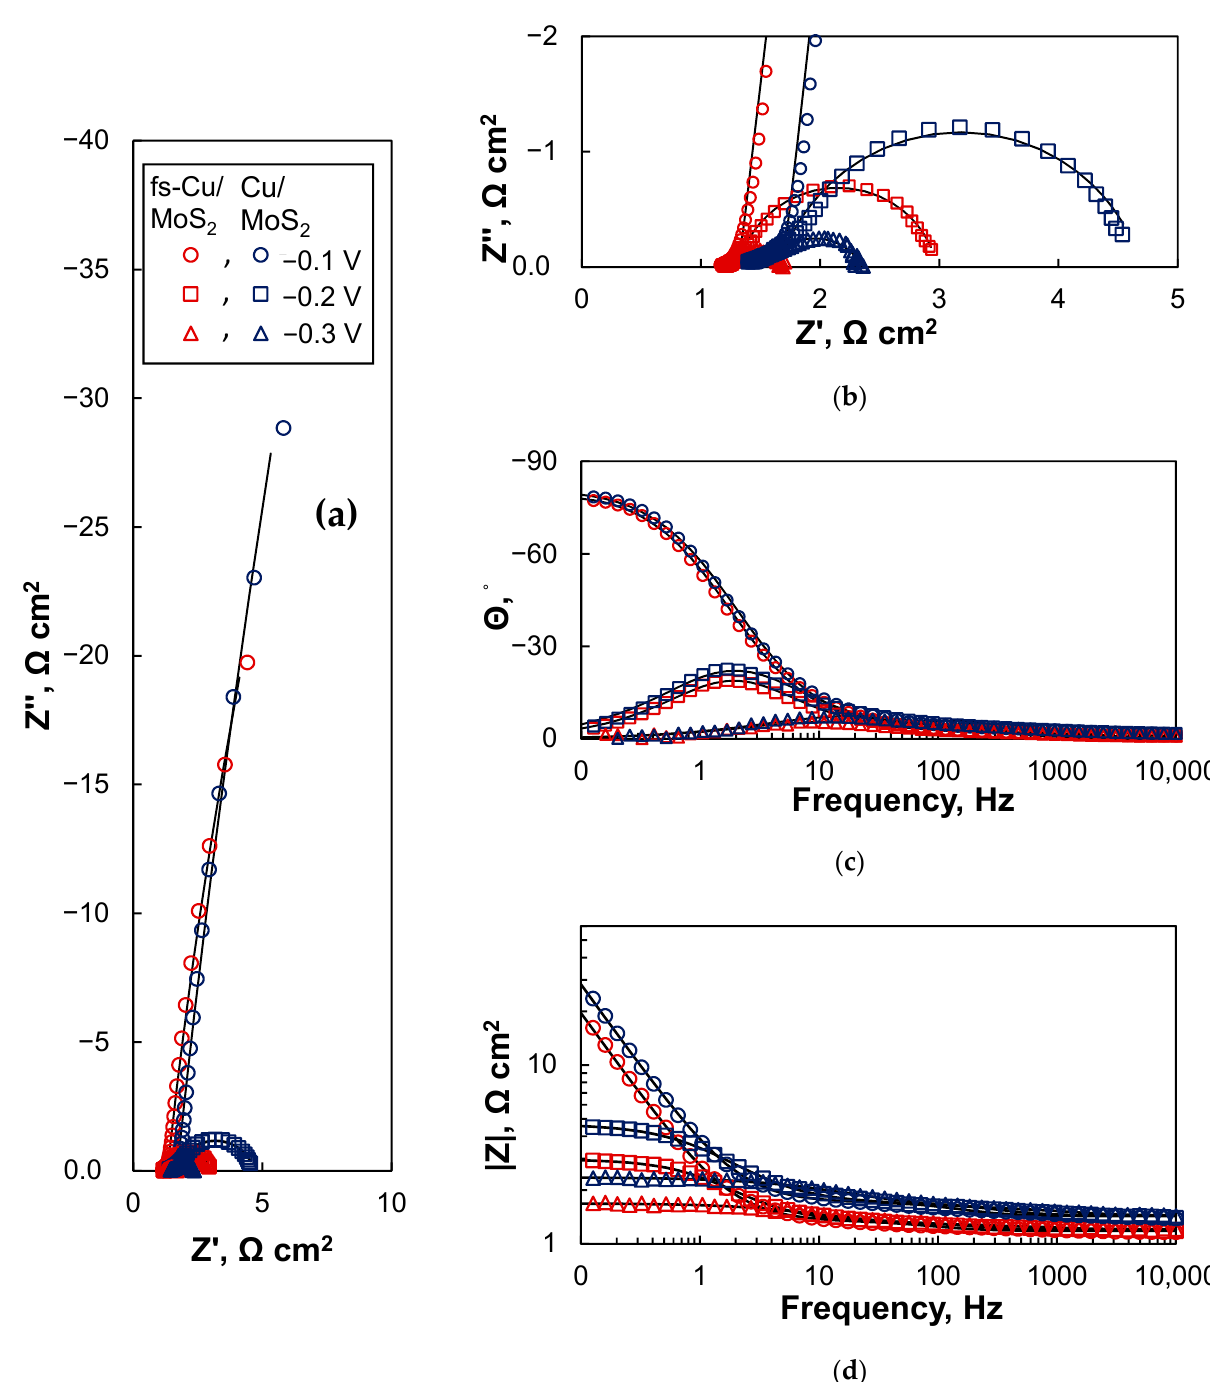
Figure 9. The EIS spectra of the Cu/MoS 2 and fs-Cu/MoS 2 electrodes in the ( a , b ) Nyquist complex coordinates and ( c , d ) bode coordinates. Solid lines were fit to the equivalent circuits shown in Figure 10.